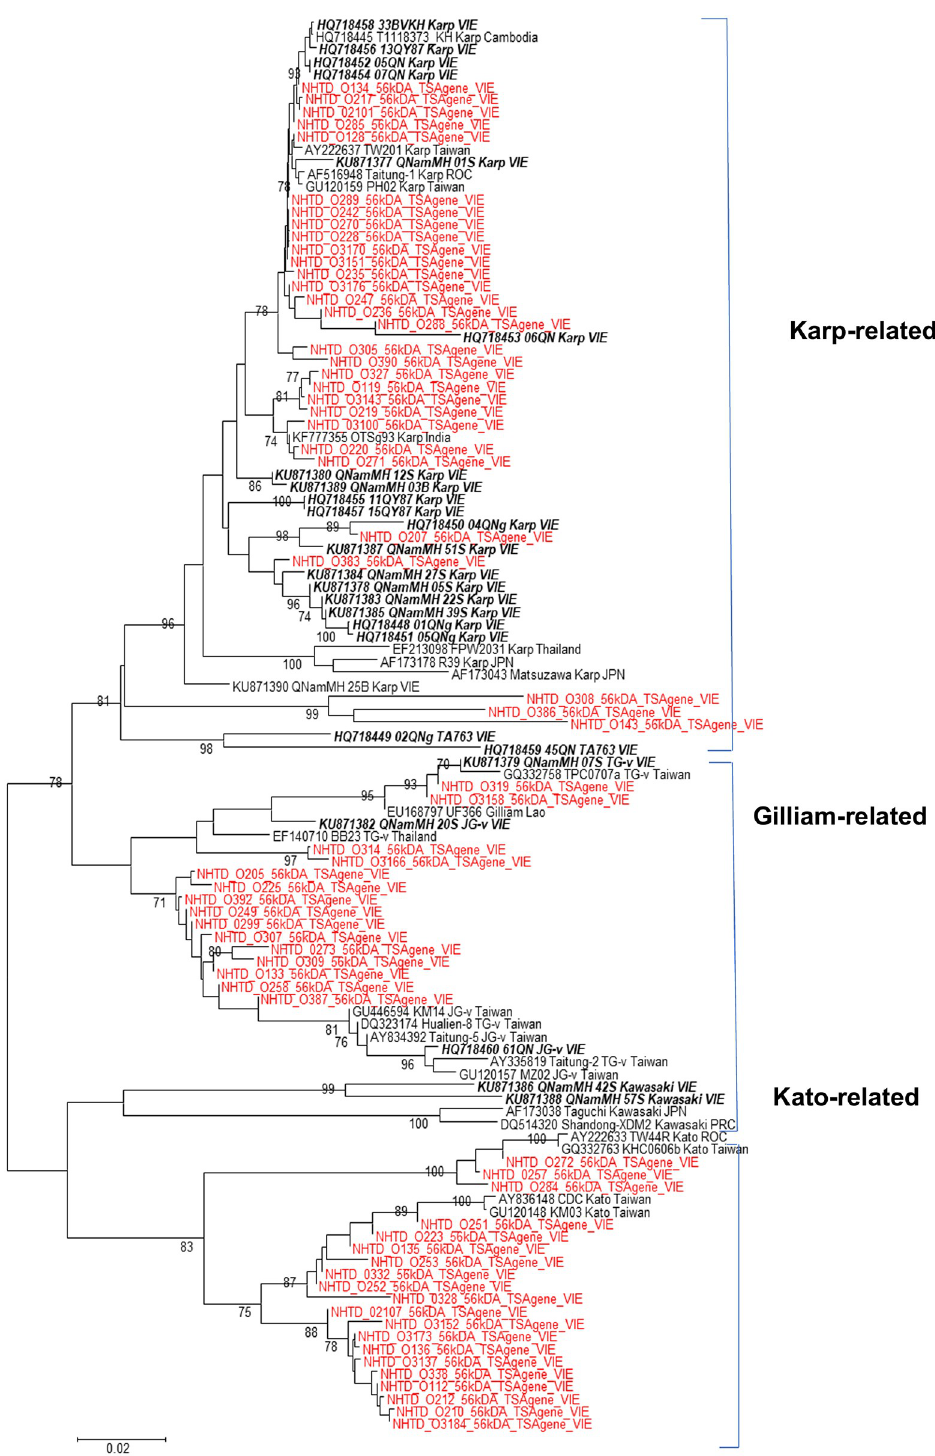
Fig 2. Phylogenetic tree of O . tsutsugamushi , based on 56-kDa TSA gene sequences. Sequences from this study are indicated with red font and other sequences from Vietnam in bold italic black font. Sequences from other countries are indicated with regular black